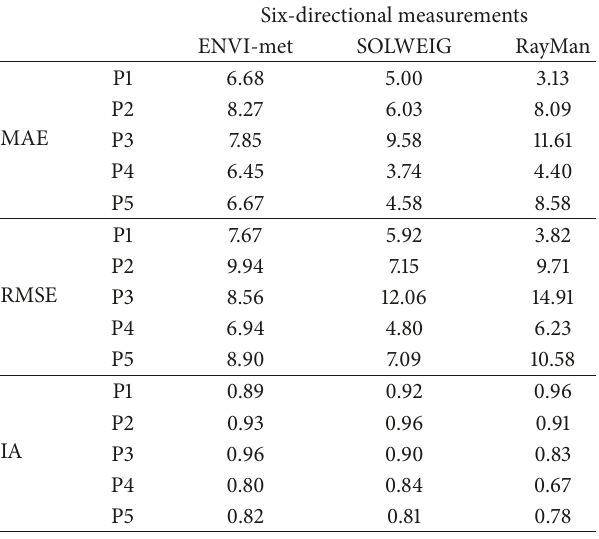
Table 1: Summary of the statistical analysis. Six-directional